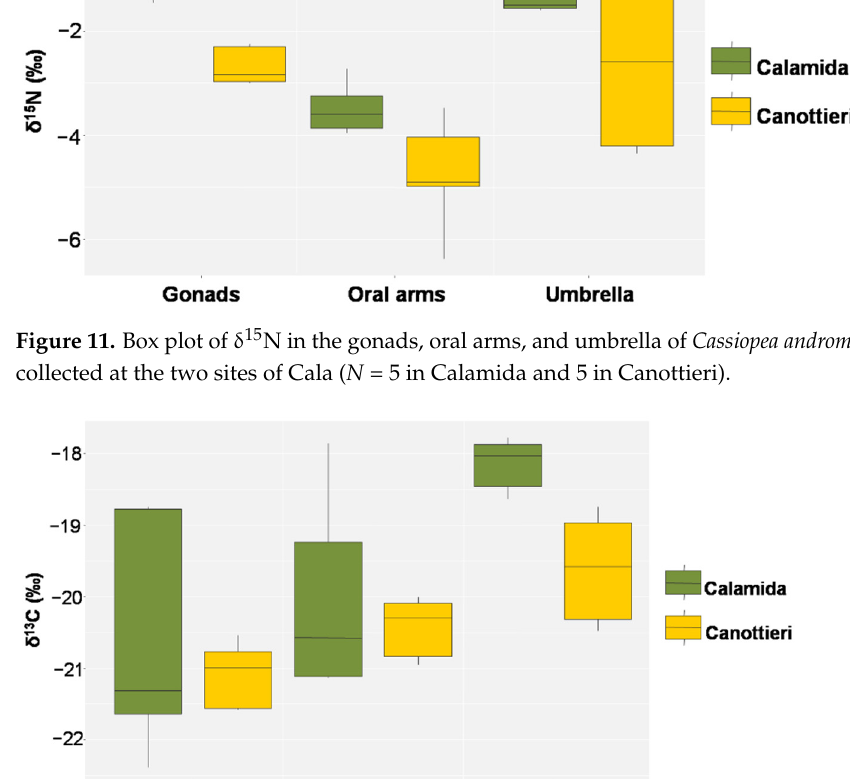
Figure 12. Box plot of δ 13 C in the gonads, oral arms, and umbrella of Cassiopea andromeda individuals